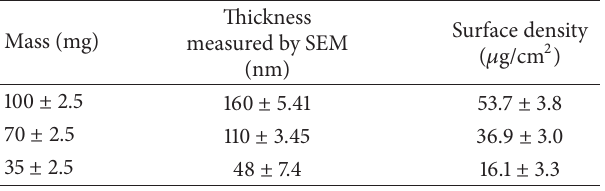
Table 2: Thicknesses of deposited films in terms of material mass that has been used for each evaporation.